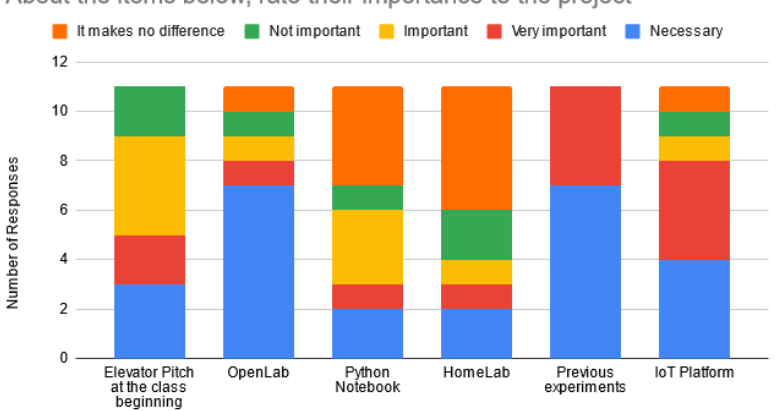
Figure 8. Item importance to the project.